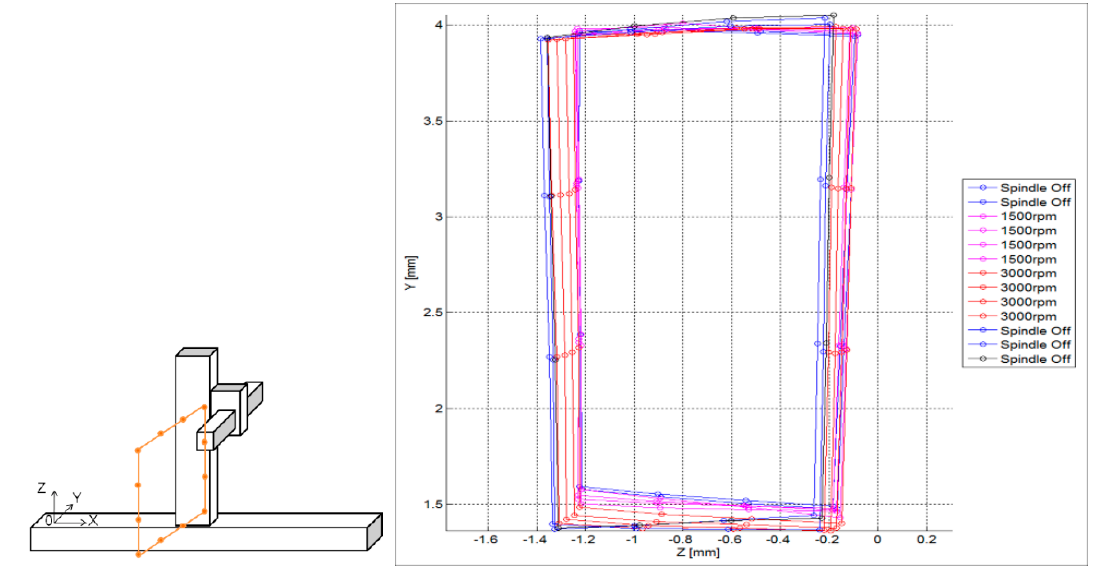
Figure 12. YZ plane measurement and thermal drift assessment on the YZ plane [127].